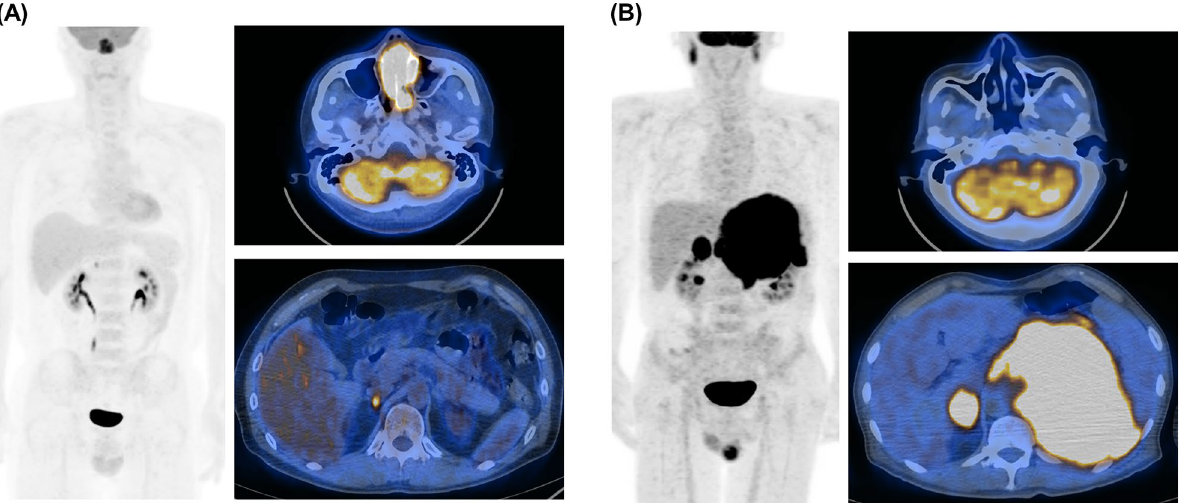
Figure 2. Representative PET/CT images of ENKTL patients. ( A ) Maximum intensity projection (left) and transaxial fusion PET/CT (right) images of a 50-year-old male showing tumor with highest SUVmax in the nasal cavity (MTV = 43, TLG = 318). The patient had a single IS-favoring PET pattern (small adrenal FDG lesion) and was confirmed to have IE-A subtype. ( B ) Maximum intensity projection (left) and transaxial fusion PET/ CT (right) images of a 56-year-old male with tumor lesions in adrenal glands and testis. The patient had normal nasal cavity uptake but high MTV and TLG on adrenal lesions. This case had all four IS-favoring PET patterns and was confirmed to have IS